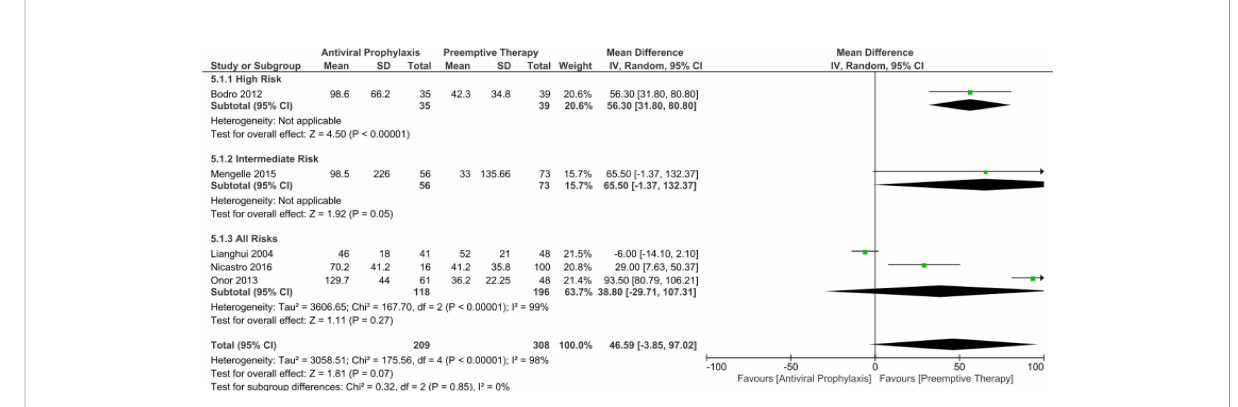
prophylaxis and preemptive therapy, our meta-analysis failed to fi nd any signi fi cant difference in the incidence of leukopenia between antiviral prophylaxis and preemptive therapy: (RD: